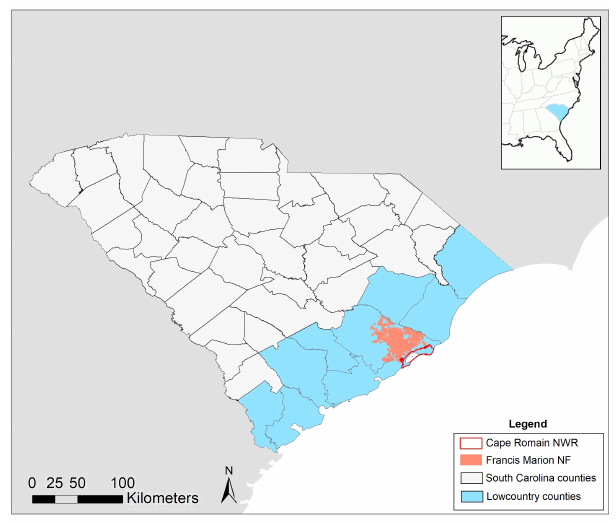
Fig. 1 . South Carolina Lowcountry, Cape Romain National Wildlife Refuge (NWR), and Francis Marion National Forest